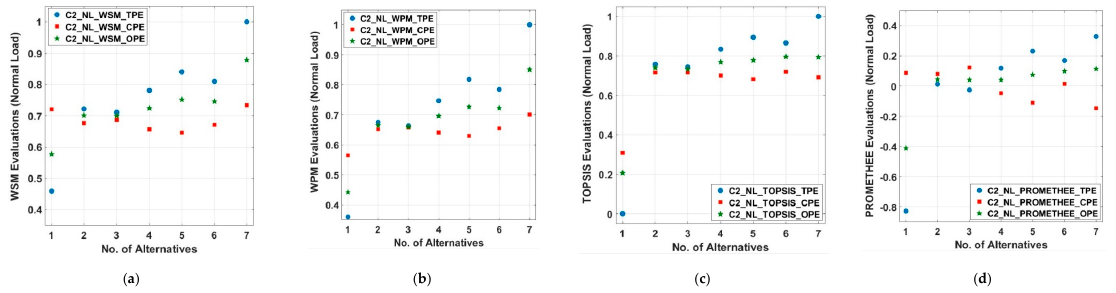
Figure 6. MCDM evaluations for C2_NL in 33-bus MDN: ( a ) WSM scores; (b) WPM scores; ( c ) TOPSIS scores; ( d ) PROMETHEE scores.